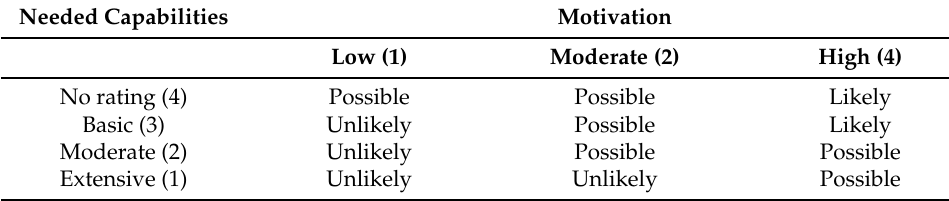
Table 5. Likelihood Assessment.